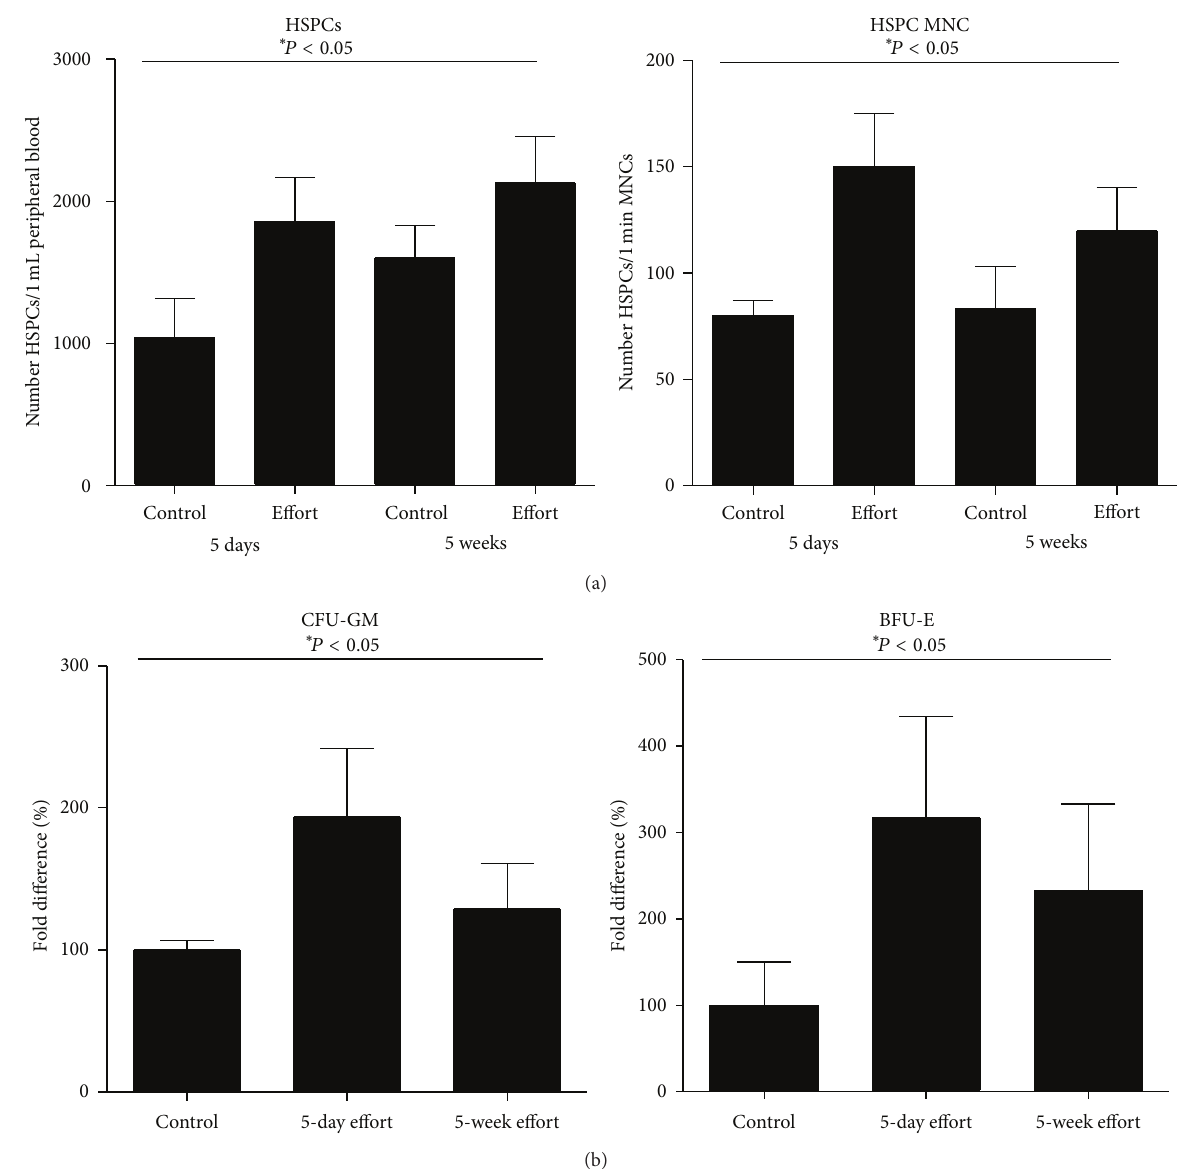
Figure 3: Effect of 5 days or 5 weeks of exercise on a treadmill on the number of HSPCs in PB and BM. (a) The number of HSPCs circulating in PB (left panel) and BM (right panel) after 5 days or 5 weeks of exercise on a treadmill (effort) compared with nonexercising mice (control). (b) The increase in the number of clonogenic progenitors (CFU-GM, left panel, and BFU-E, right panel) in BM after 5 days or 5 weeks of exercise on a treadmill (effort) compared with nonexercising mice (control) ( 𝑛 = 6 mice/group).